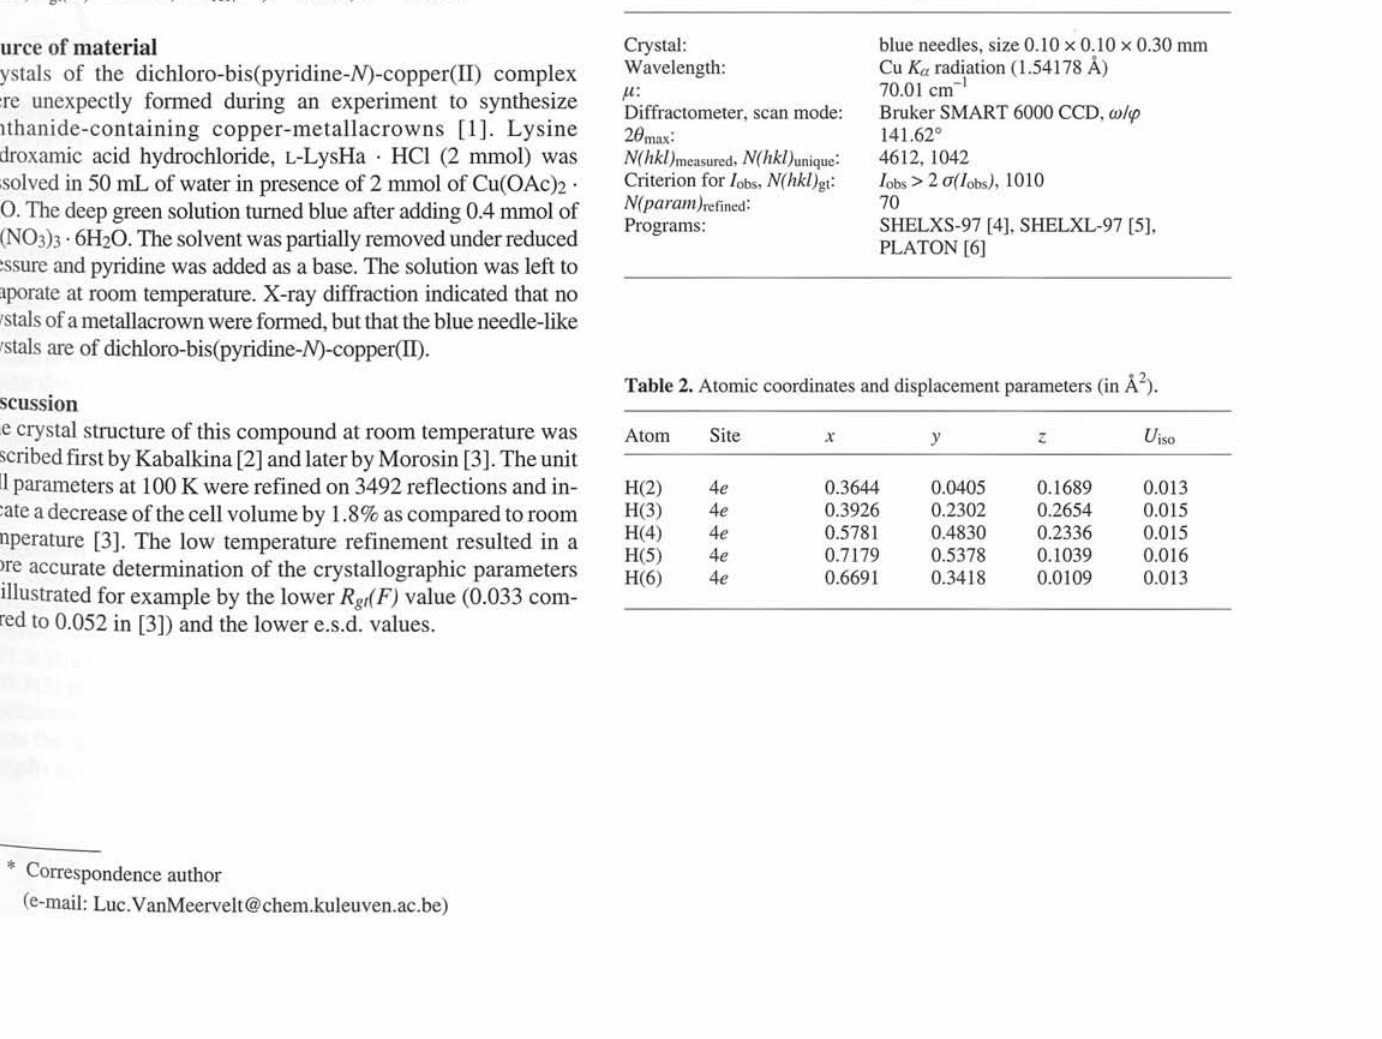
Table 1. Data collection and handling.